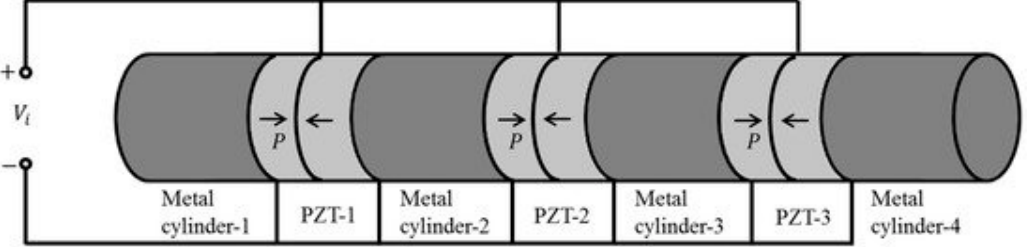
10 of 25 Figure 10. Schematic diagram of piezoelectric ring with metal ring ( left ) and its electromechanical equivalent circuit ( right ).